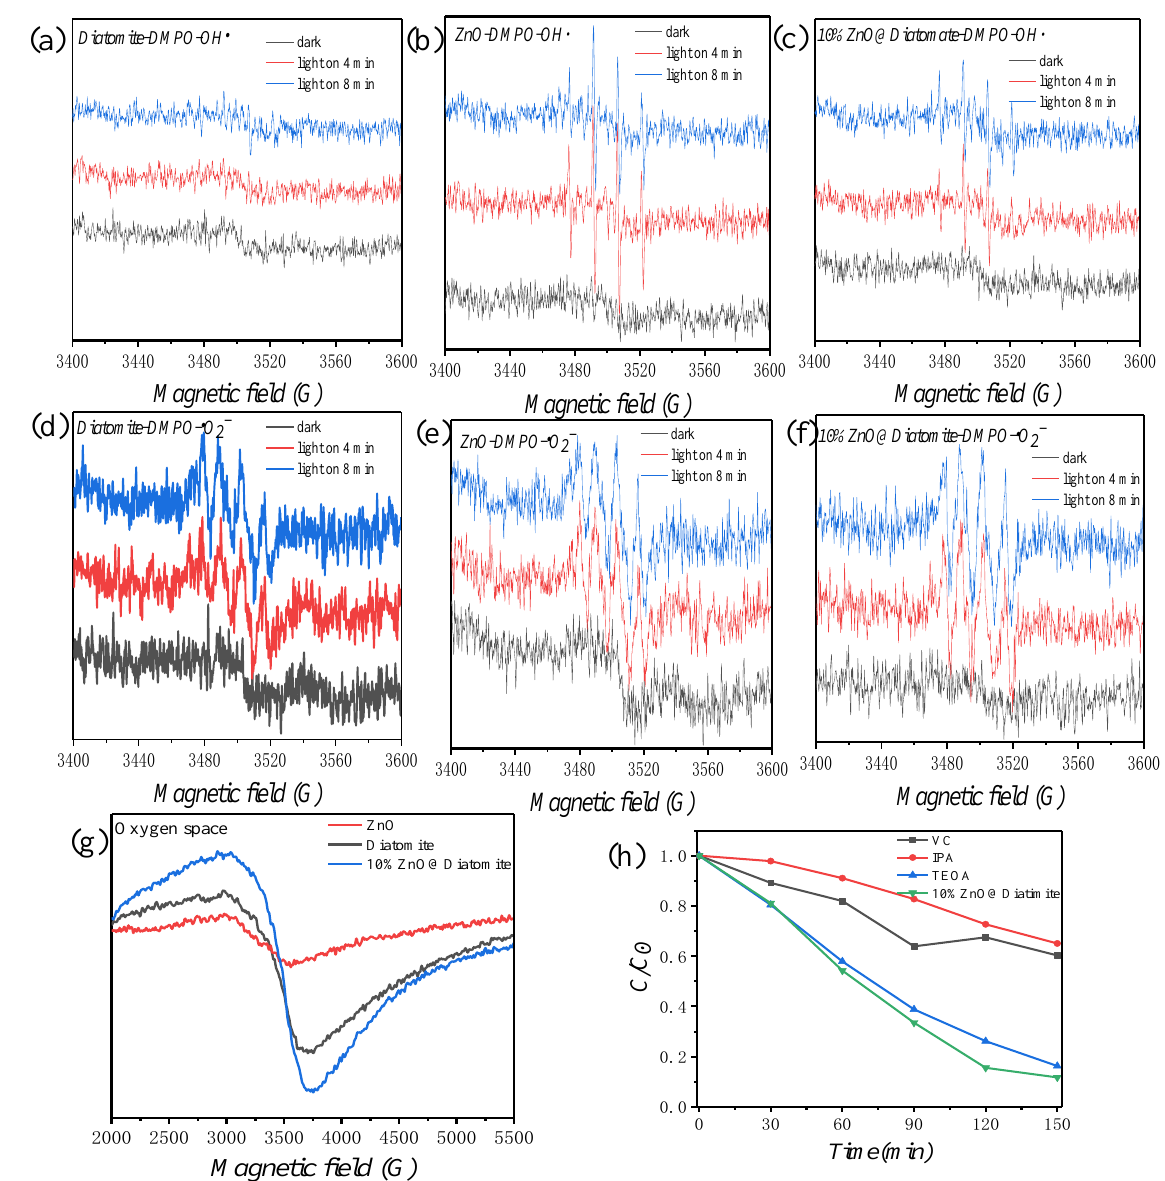
Figure 4. EPR spectra of the samples: ( a )·OH in diatomite; ( b )·OH in pure ZnO; ( c )·OH in 10%ZnO@diatomite; ( d ) ·O −2 in diatomite; ( e )·O −2 in pure ZnO; ( f ) ·O −2 in 10%ZnO@diatomite; ( g ) oxygen vacancy; ( h ) degradation rate of MB solution by 10%ZnO@diatomite with the addition of free radical scavengers.